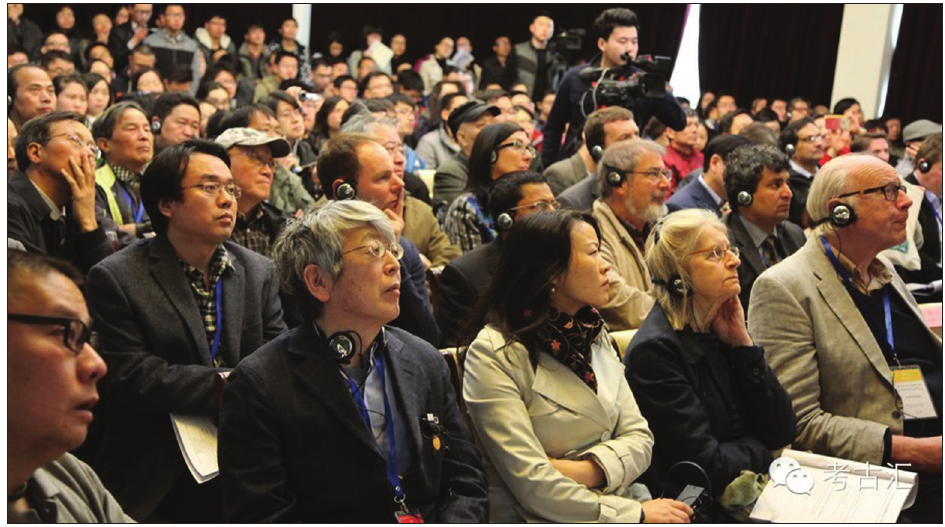
Figure 1: International engagement at our most recent conference, ‘Dialogue of Civilizations’. Photo: